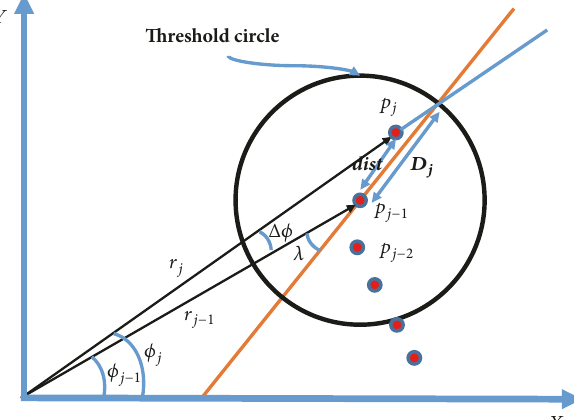
Figure 4: Schematic diagram of the Iterative Endpoint Fit (IEPF)